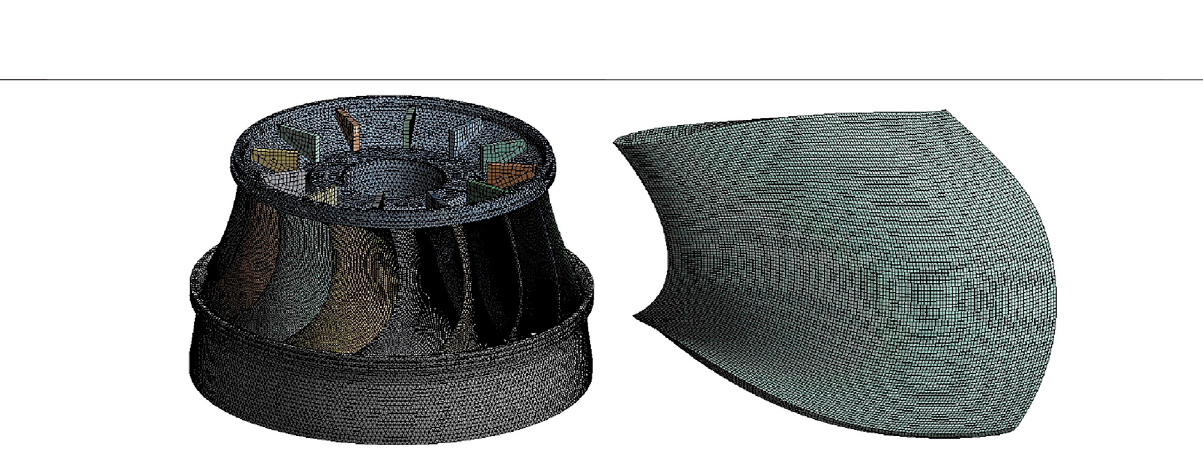
FIGURE 17 | The structure fi nite element calculation model of the runner and blade.